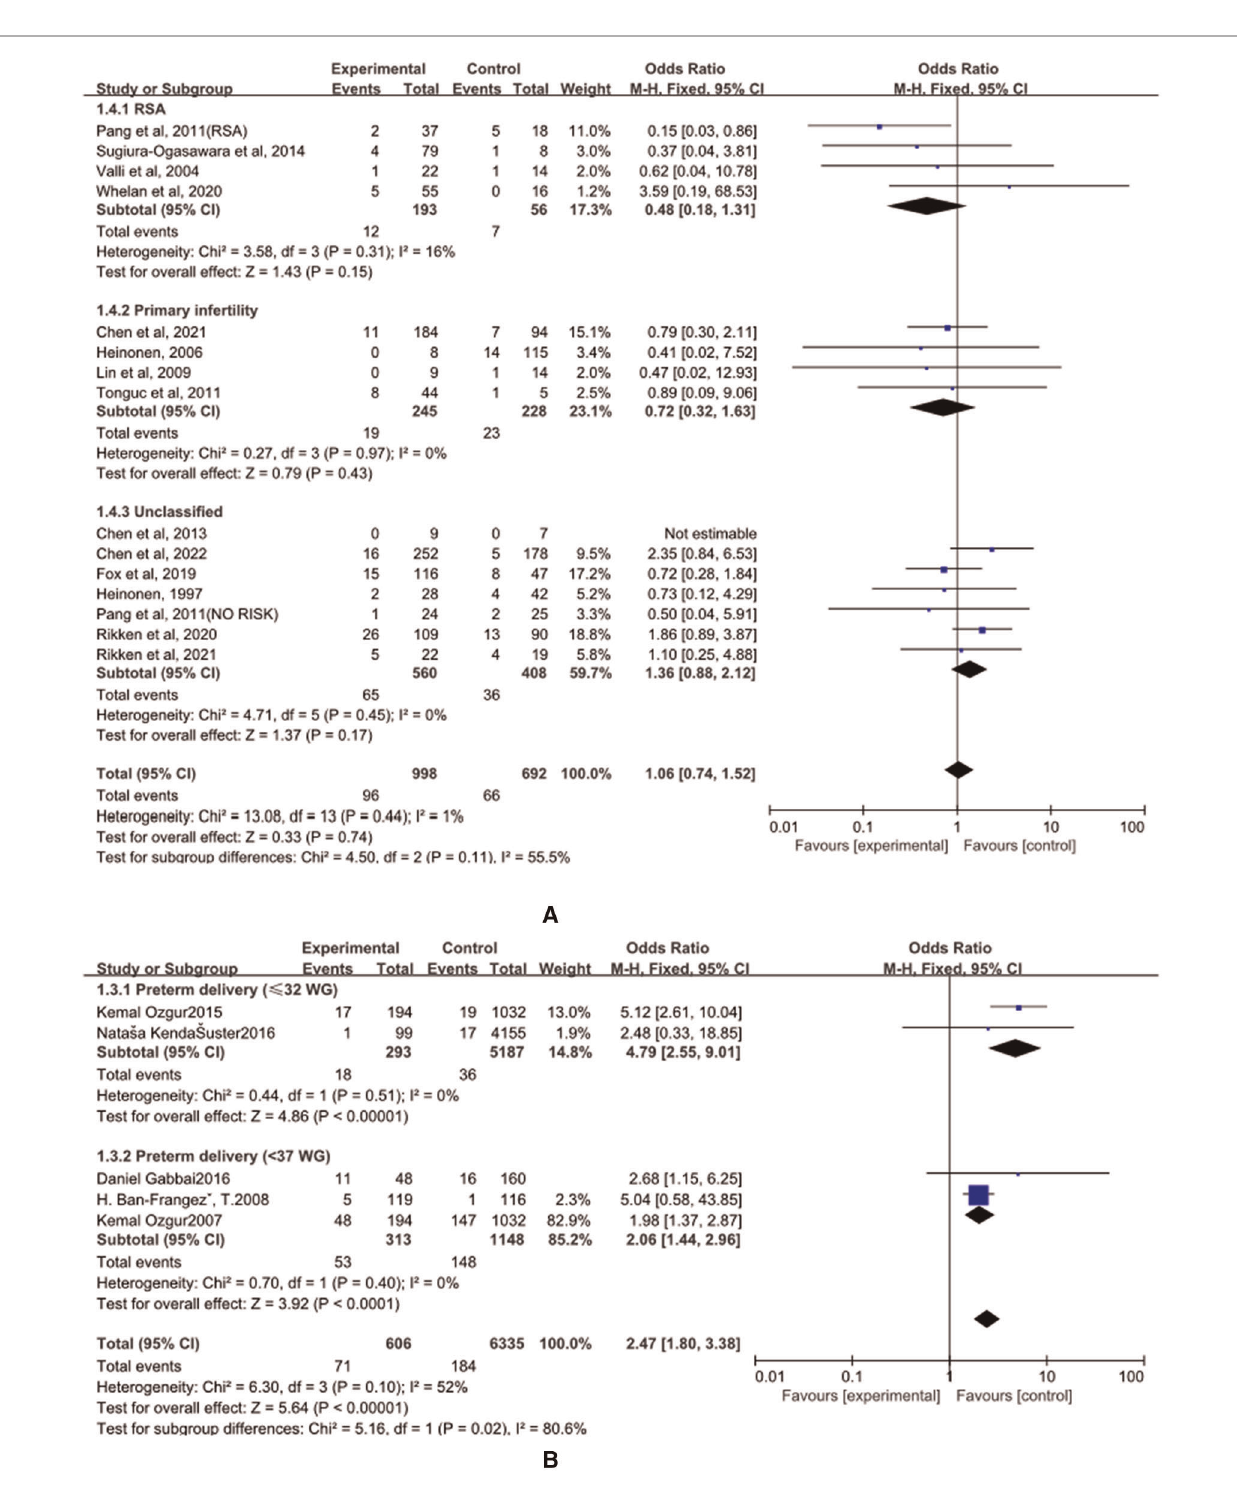
FIGURE 5 | Effect of hysteroscopic resection on preterm delivery. ( A ) The control group of untreated women with septum uterus, and the study group was patients who underwent hysteroscopic surgery. ( B ) The control group of these articles was women with intact uterus, and the study group was patients who underwent hysteroscopic